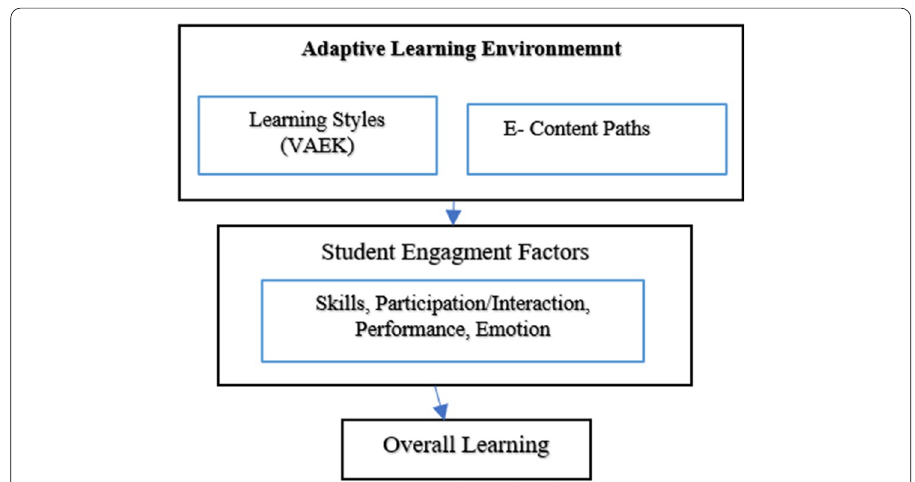
Fig. 6 The conceptual framework (model) of the research